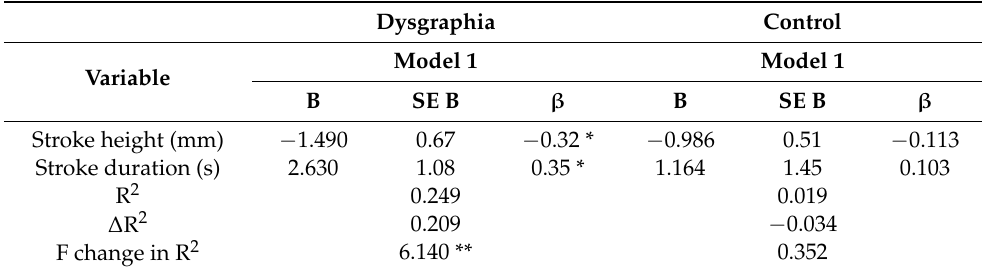
Table 7. Prediction of physical QOL by handwriting measures among adolescents with dysgraphia and the control